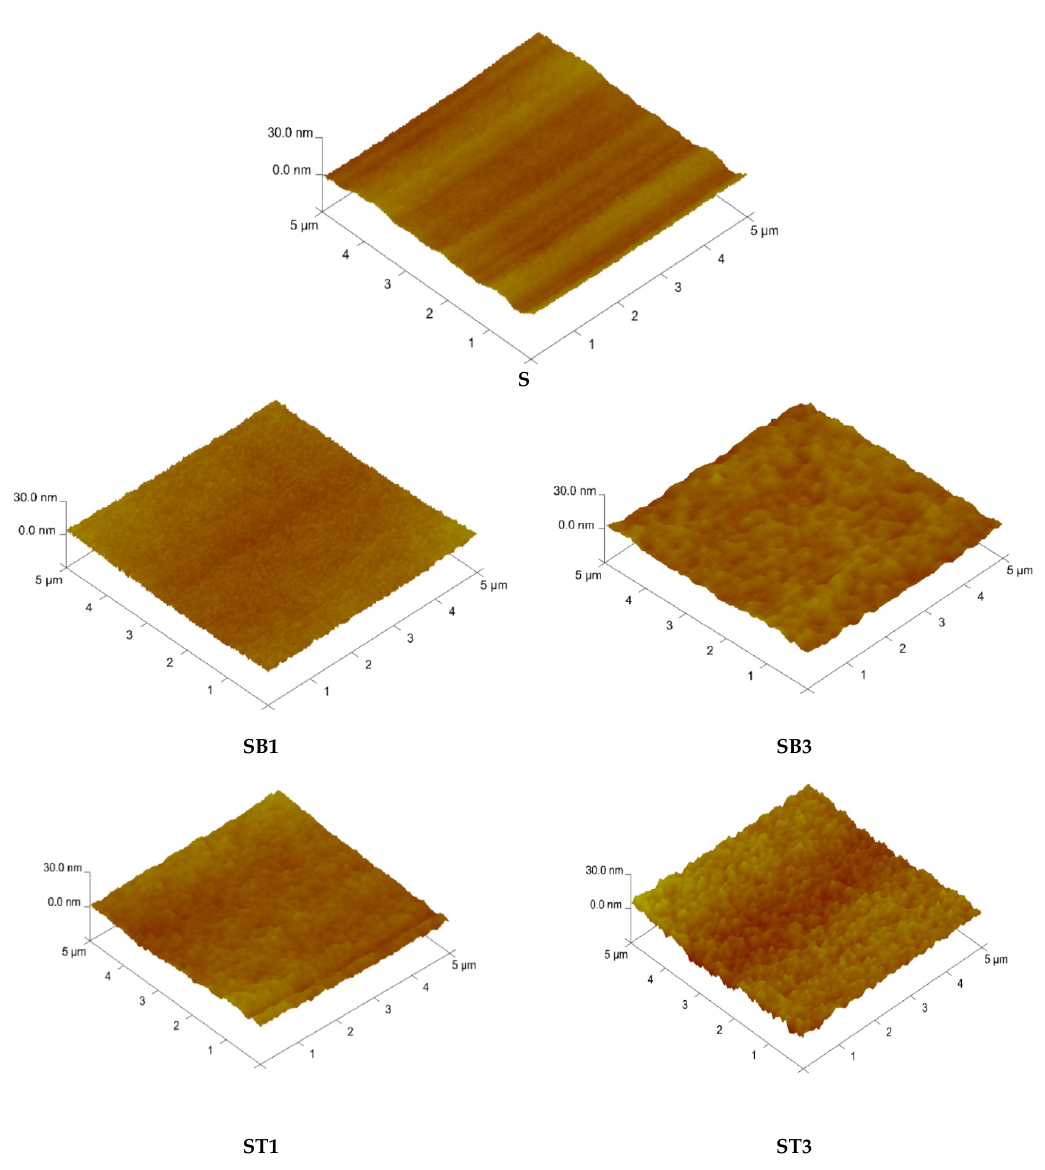
Figure 6. Atomic force microscopy images of unfilled polymer matrix and its composites.